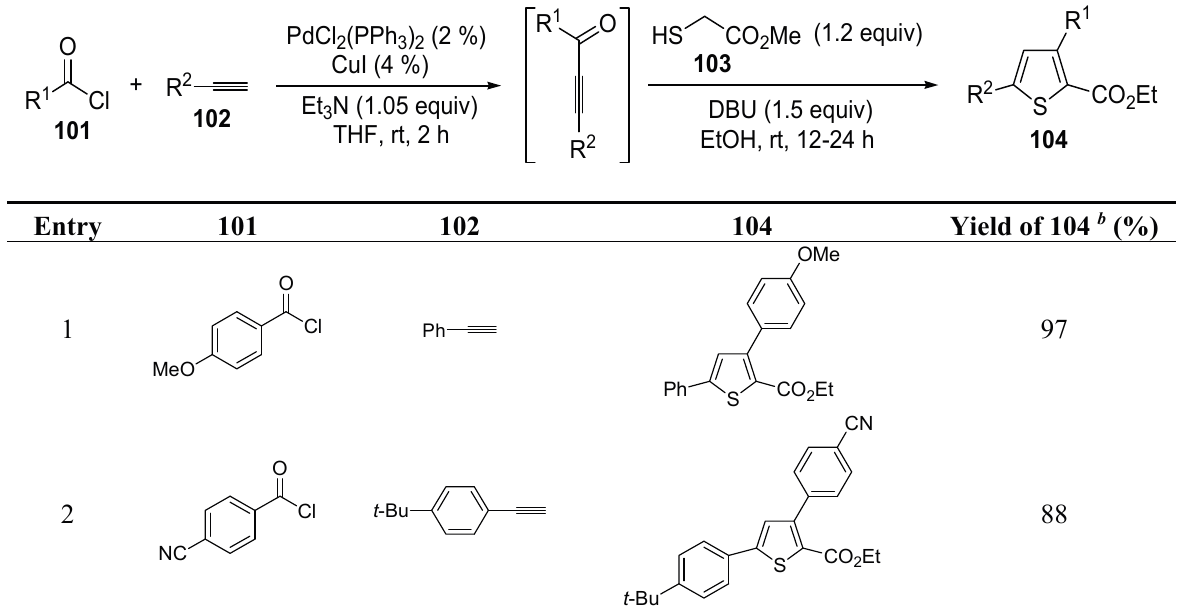
Table 9. Synthesis of ethyl thiophene-2-carboxylates 104 starting from sequential